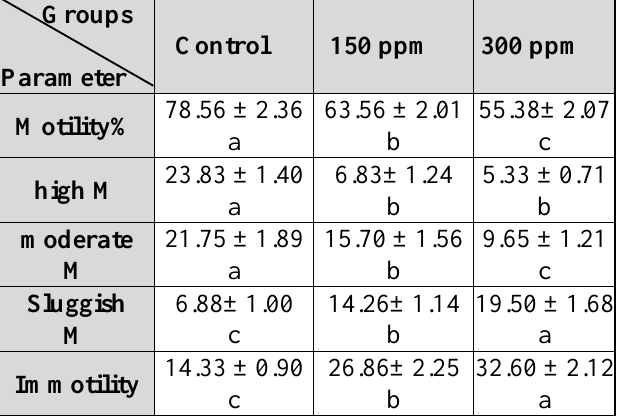
Table 1. Effects of different sub lethal concentrations of sodium fluoride given with drinking water on general sperm motility of male rats (%), mean ± SE